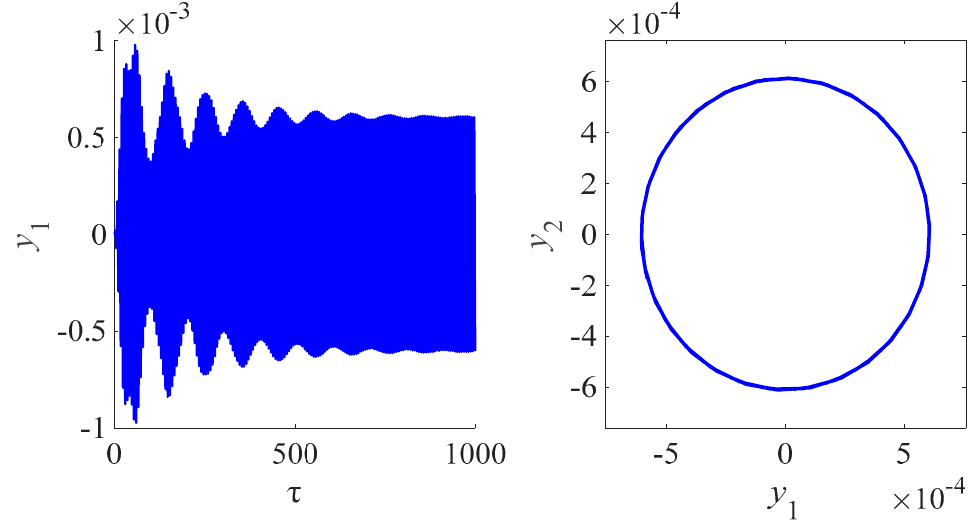
Figure 8. Time domain and frequency domain diagram for circuit charge of different phase difference of the Josephson junction for the magnetic field 6 T.